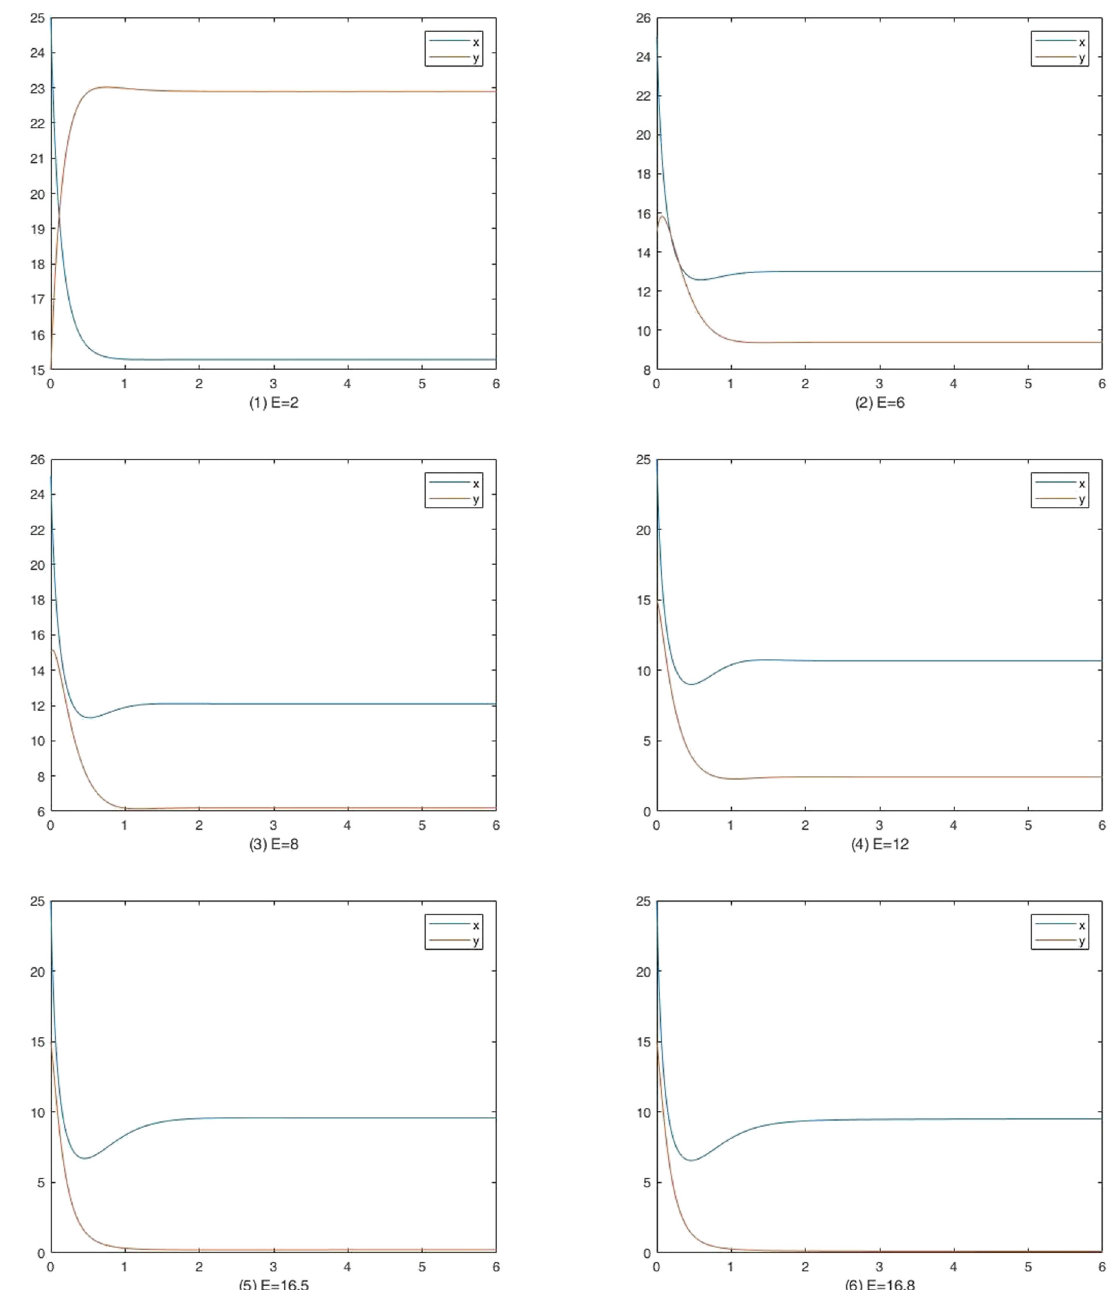
Figure 1: Persistence with di ff erent harvesting e ff